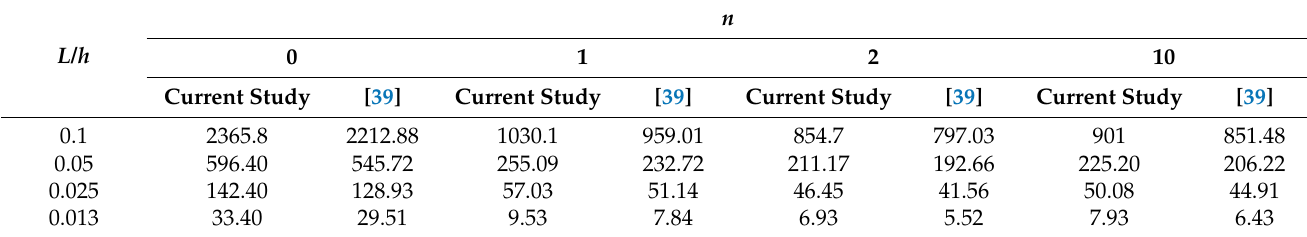
Table 4. Critical bucking load of FGM beam with S-S supports for different value of n and L⁄h.